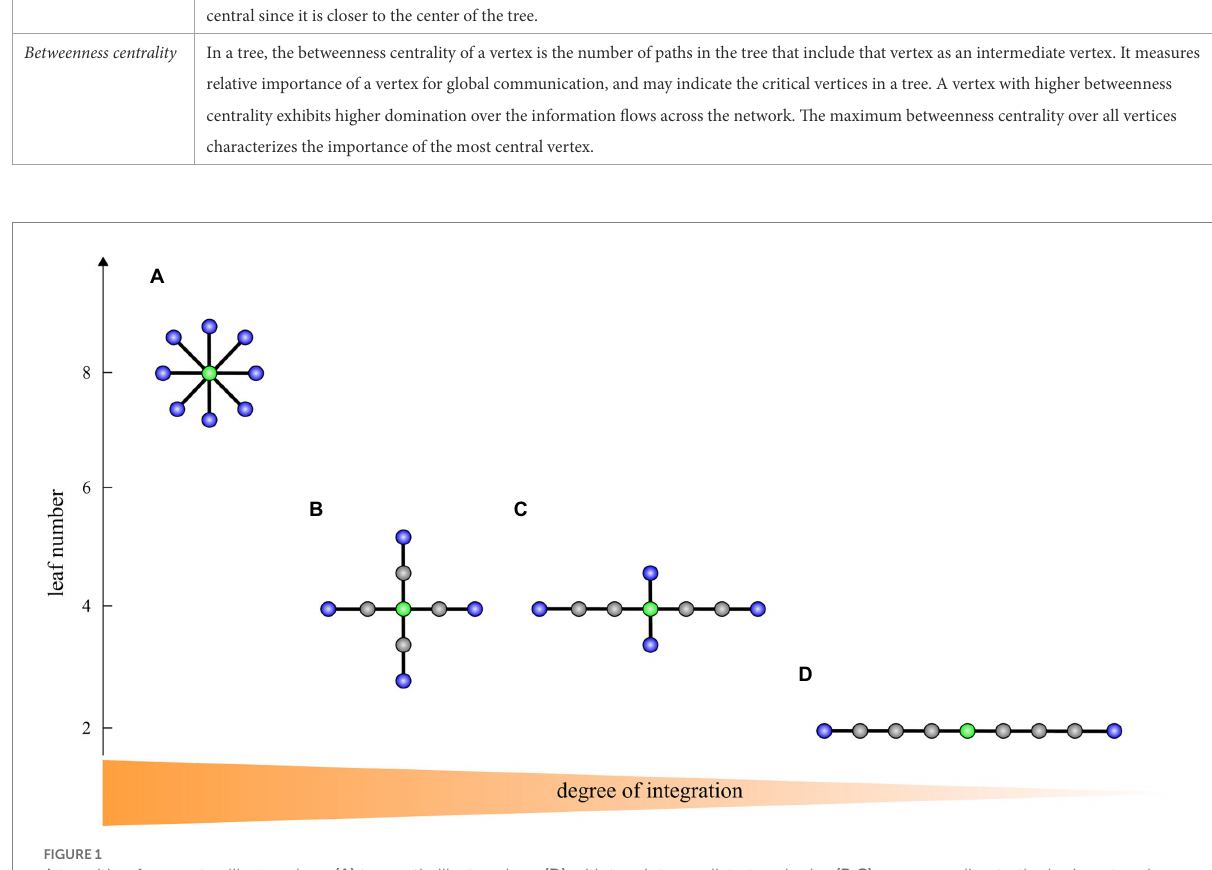
The demographic characteristics of participants and discrimination task are given in Table 1. The Motion direction discrimination task did not differ significantly between the groups.